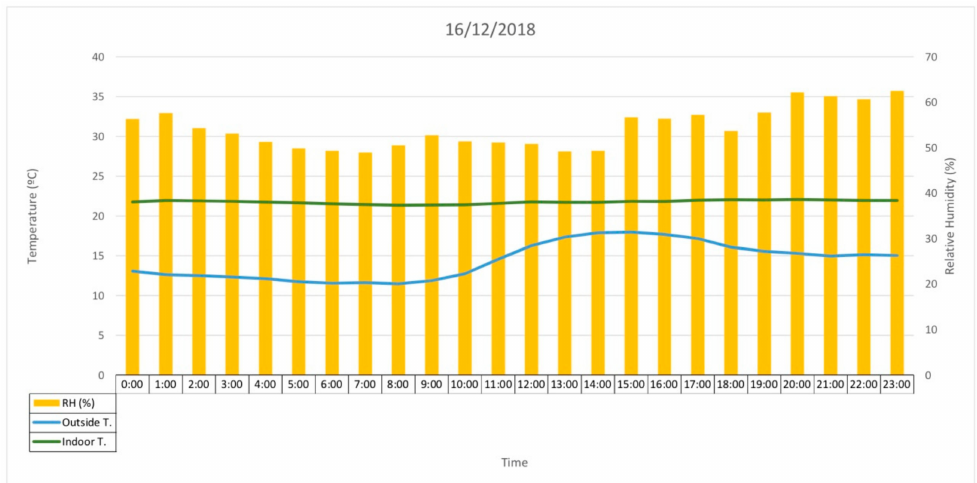
Figure 23. Hourly evolution of temperature and relative humidity after refurbishment in a random winter day.